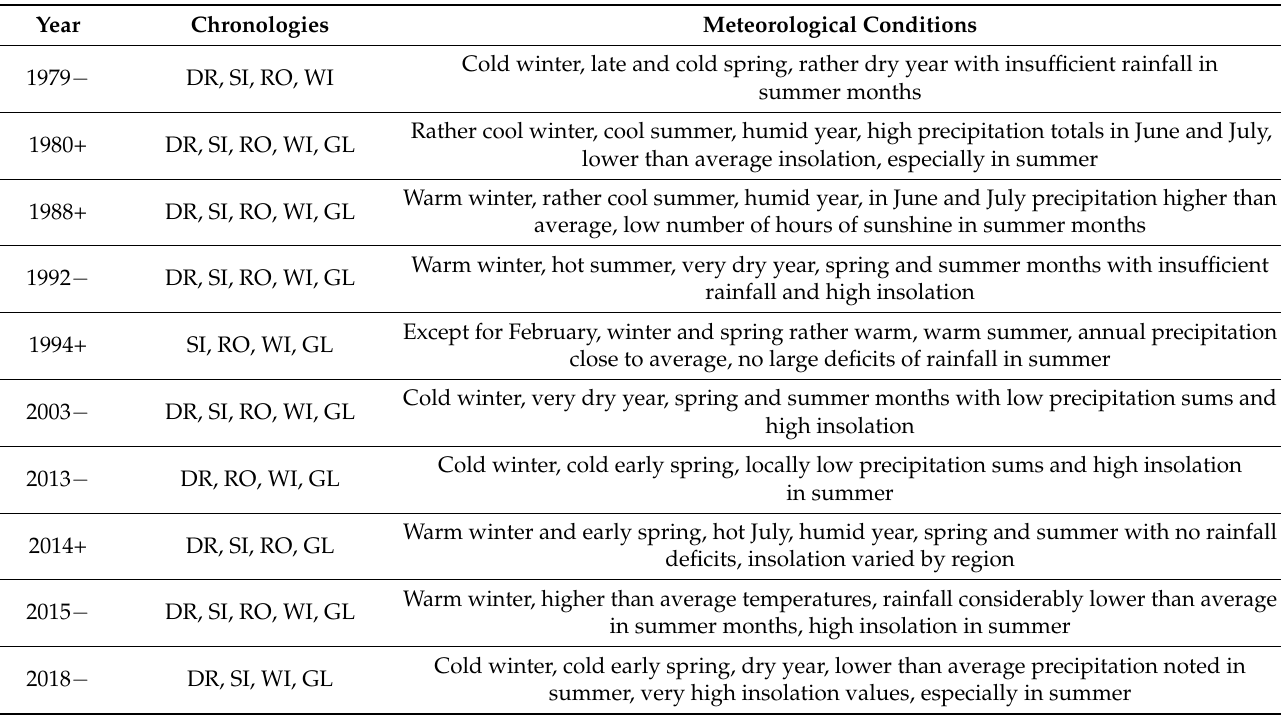
Figure 6. Tree-ring width (D) during regional pointer years (converted to dimensionless values). Table 5. Regional pointer years, + denotes positive and − denotes negative pointer